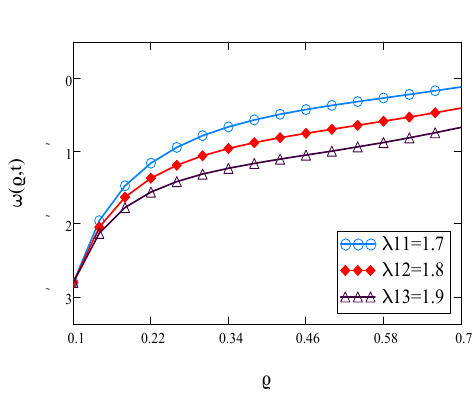
Figure 3. The influence of velocity w ( (cid:36) , t ) for R i = 0.1, R o = 0.7, β = 0.85, t = 1.87, A = 5, ν = 0.35 and Ω = 2 with various values of (cid:105) .